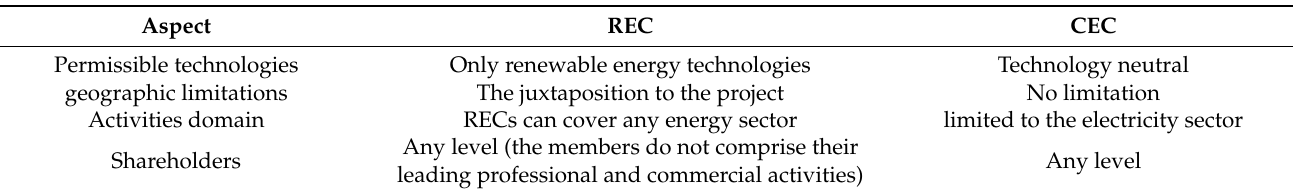
Table 1. Key differences between REC and CEC [67].